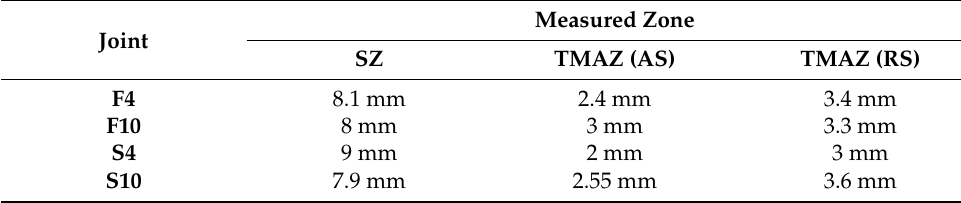
Table 5. The sizes of welded zones at mid-thickness of different joints.